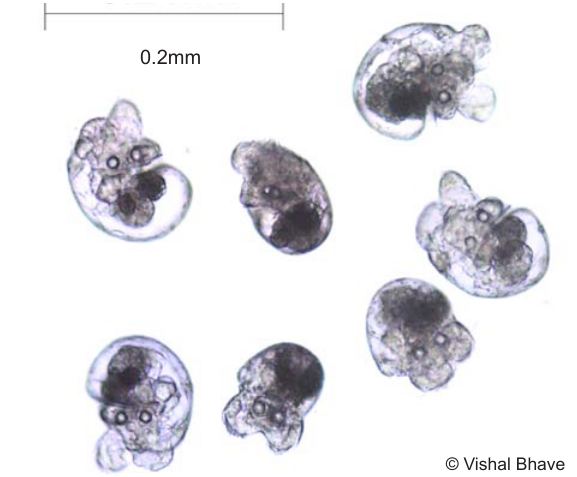
Image 7. Free swimming veligers (with eye spots and larval shells)